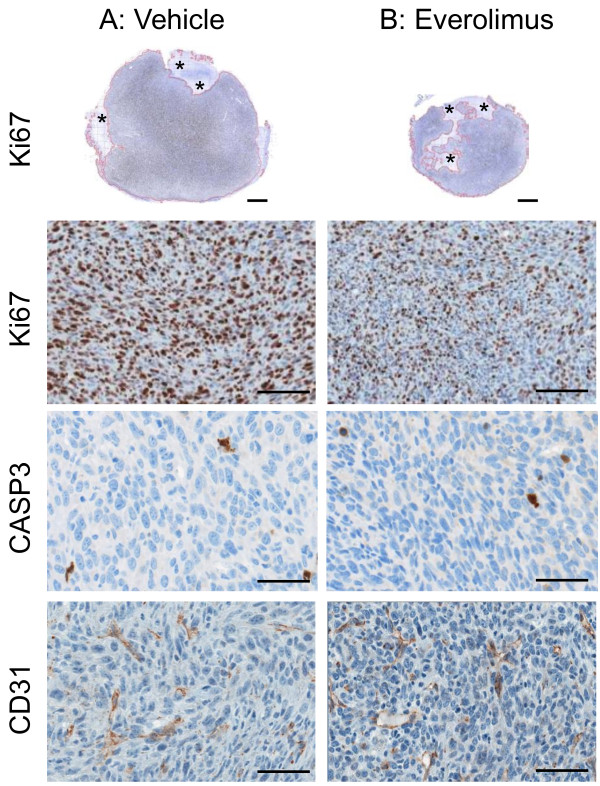
Immunohistochemistry in RIF-1 tumours after everolimus or vehicle treatment. C3H mice bearing RIF-1 tumours were treated with vehicle (A, left column) or everolimus at 10 mg/kg/day (B, right column) for 5 days prior to sacrifice (n = 7 per group). Tumours were ablated and prepared for immunohistochemistry as described in Methods. The entire sections were scanned. Ki67-stained slices of one representative tumour from each treatment (scalebar = 1 mm) are shown in row 1. Viable tumor tissue is outlined in red and necrosis regions are marked with asterisks. Percentage of Ki67-positive cells was 46% and 26% and the total tumour area was 43.9 mm2 (8% necrosis) and 22.4 mm2 (19% necrosis) for the vehicle-treated and everolimus-treated mice, respectively. Magnified sections stained for Ki67 (scalebar = 50 μm), cleaved caspase-3 (CASP3, scalebar = 25 μm), and CD31 (scalebar = 25 μm) are shown below in row 2, 3, and 4, respectively. There was no difference between the groups in apoptosis (CASP-3 staining) and blood-vessel density (CD31 staining).